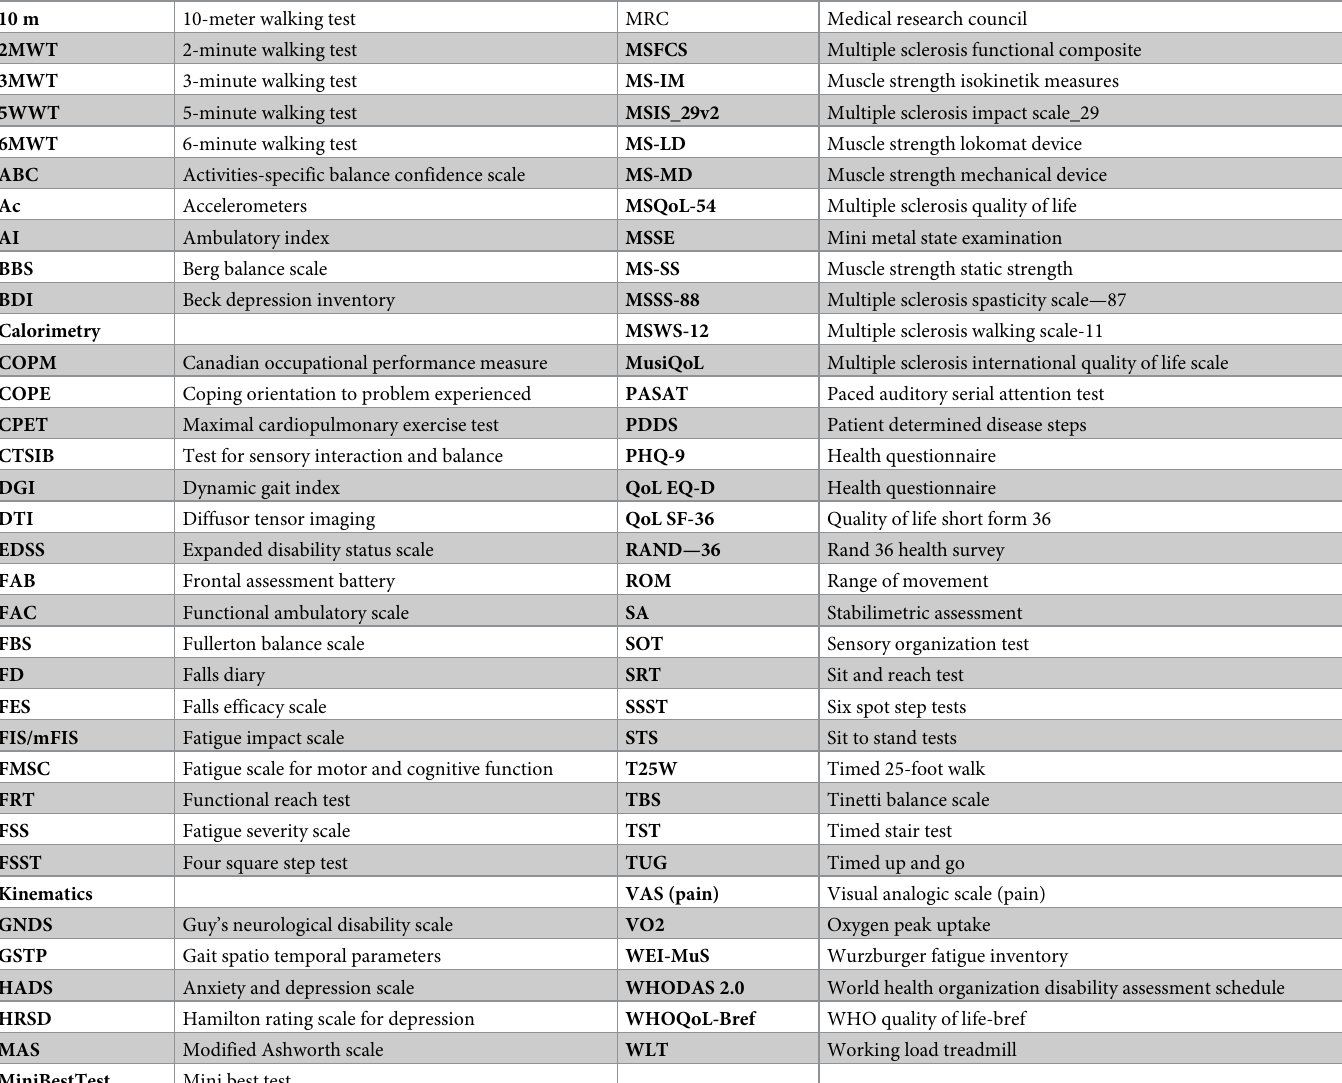
Table 2. Outcome measures found in included RCTs and their